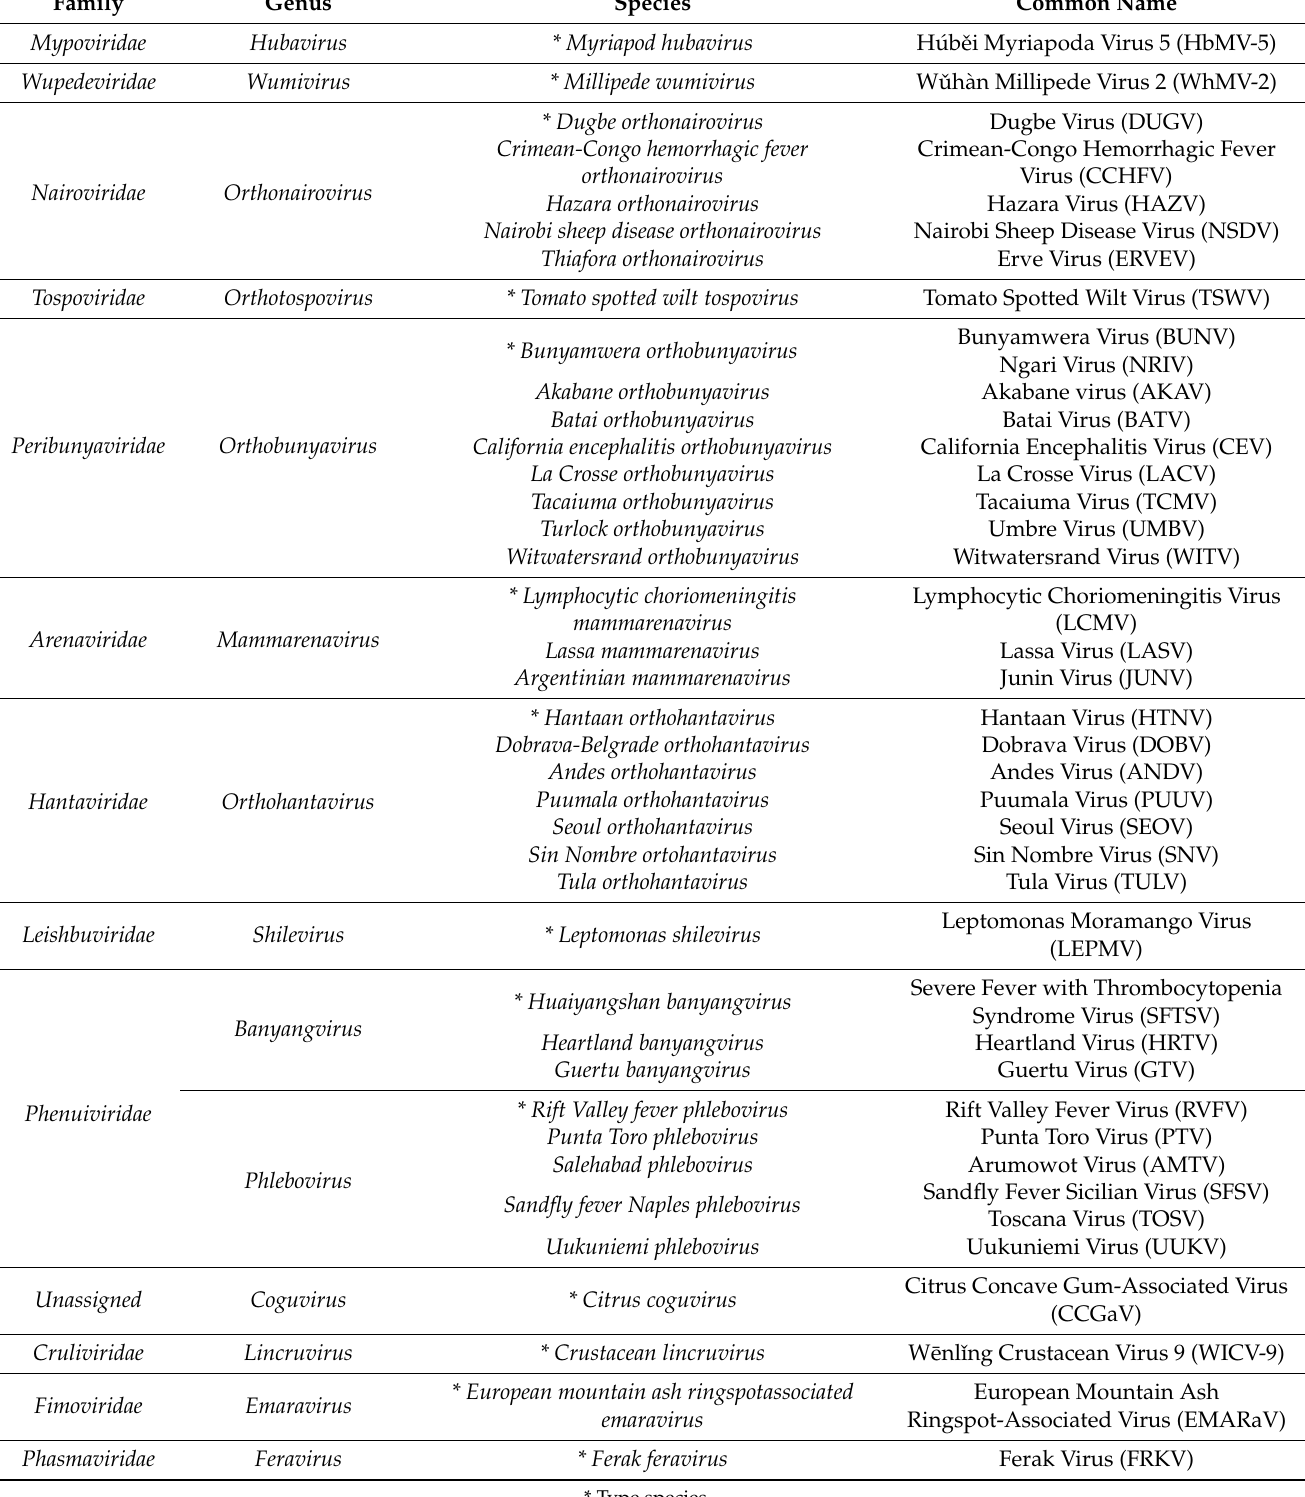
Table 1. Order Bunyavirales Taxonomy. Taxonomical classification of the 13 Bunyavirales families according to the most recent International Committee on Taxonomy of Viruses (ICTV) taxonomy update. Included are identified type species for each family as well as relevant viruses discussed in this review